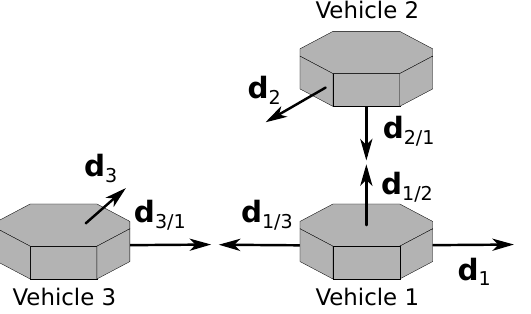
Figure 9. Ambiguous and degenerate configuration at 50 s of experience